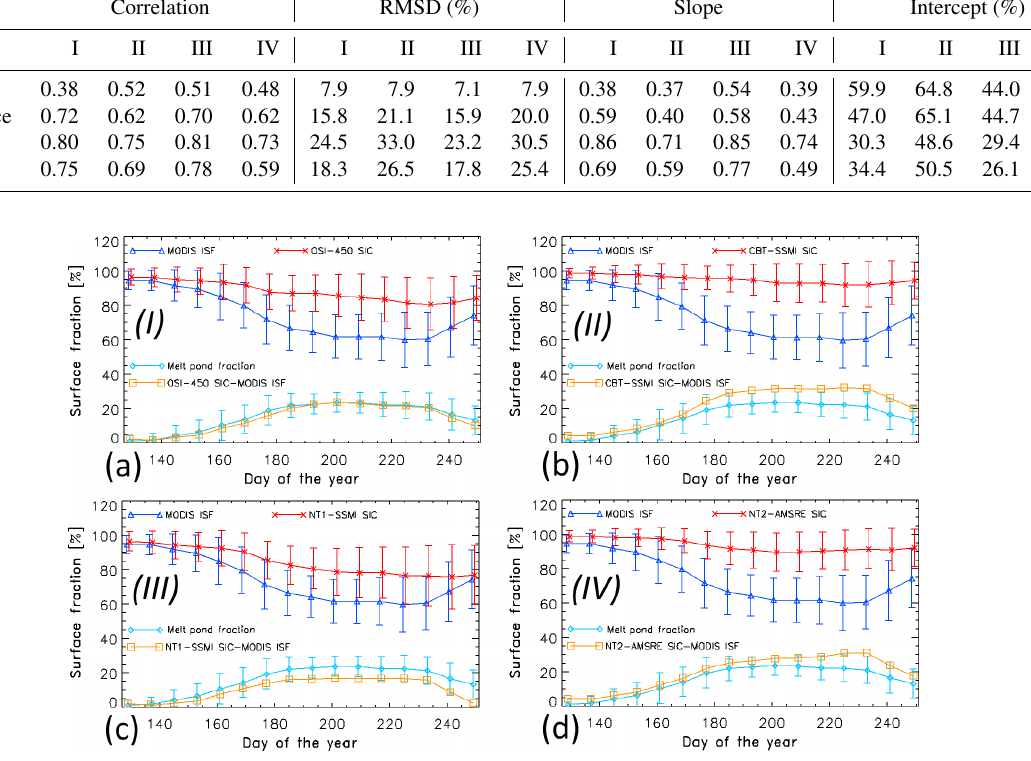
Figure 9. Average seasonal cycle of the mean (limited to Arctic Ocean and Canadian Arctic Archipelago) MODIS ISF (in blue), PMW SIC (in red), their difference of PMW SIC minus MODIS ISF (in orange), and the MODIS melt pond fraction (in cyan), averaged for each 8d period over the years 2003–2011 of the PMW products representing groups I to IV (see also Fig. S10 in the Supplement). Error bars